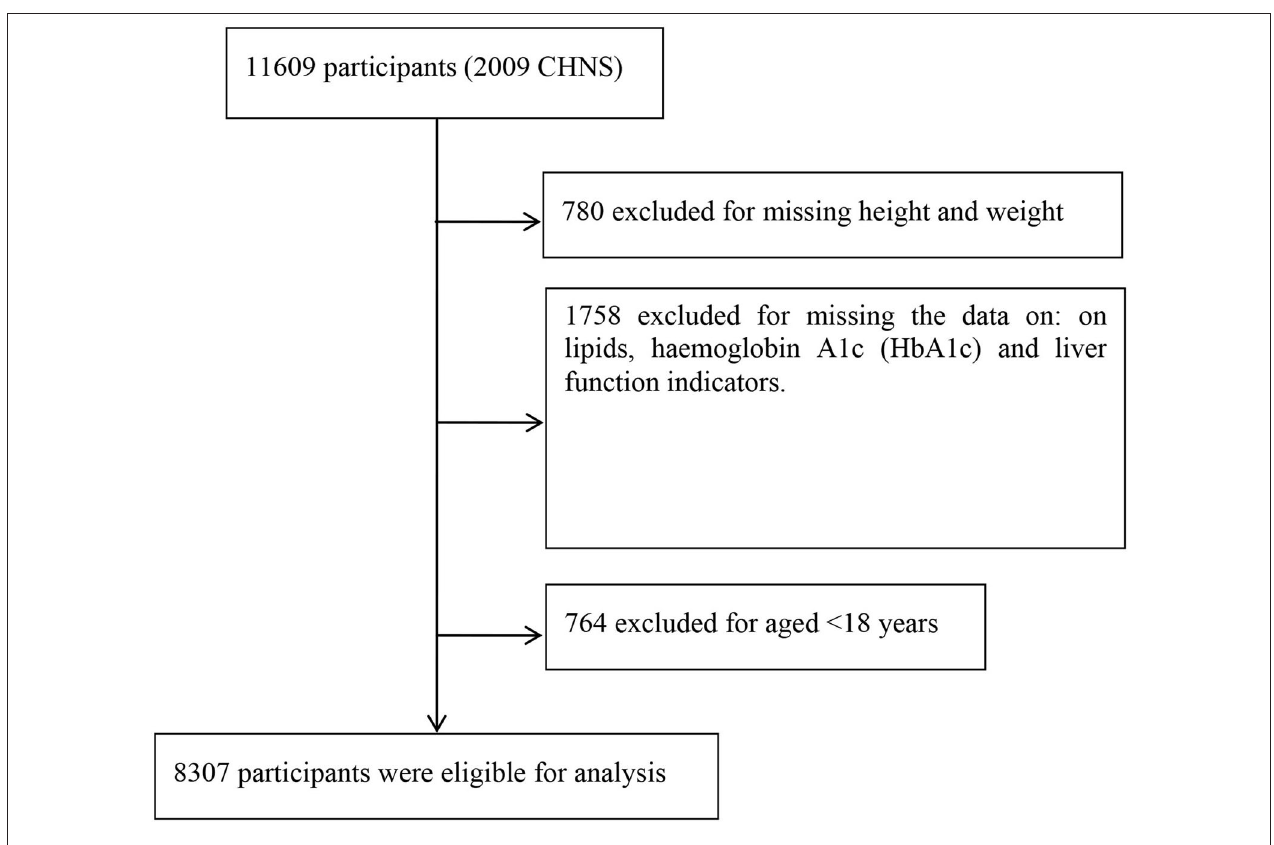
FIGURE 1 | Flowchart of study participants.